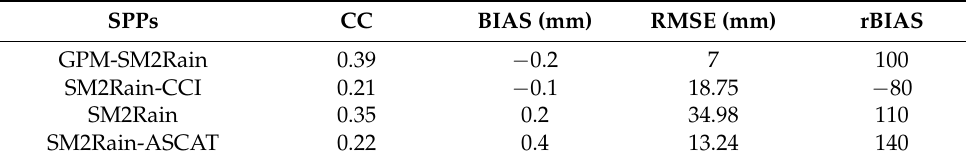
Table 4. Results of all evaluation indices on daily